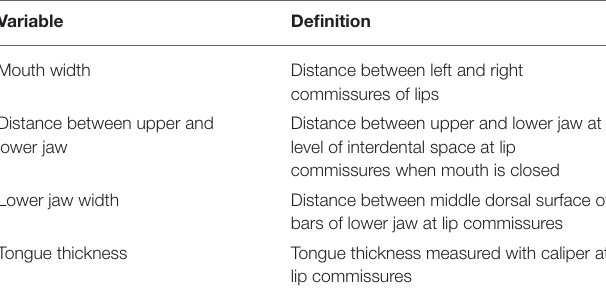
TABLE 1 | Definitions of horse oral dimensions by anatomical landmarks.